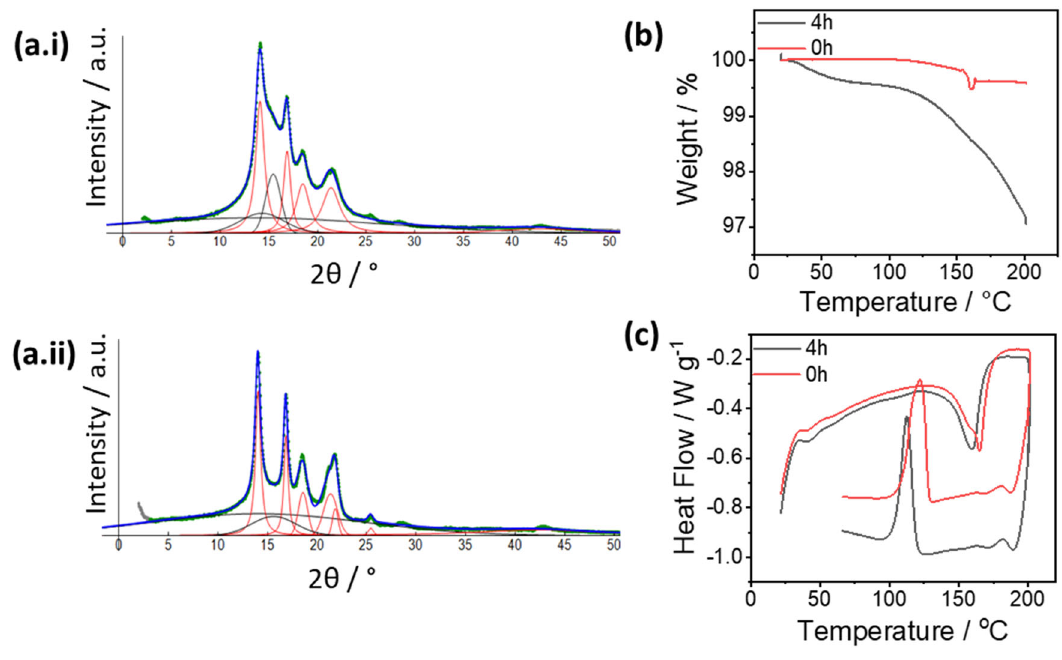
Fig. 7 WAXS, TGA and DSC analyses for the fi lter layer. a WAXS plots for the middle fi lter layer ( a.i ) before and ( a.ii ) after plasma irradiation for 4 h. Comparison on b weight loss curves from the TGA and c heat fl ow from DSC measurement of the middle fi lter layer before and after plasma irradiation. Results from other layers can be found in SI.